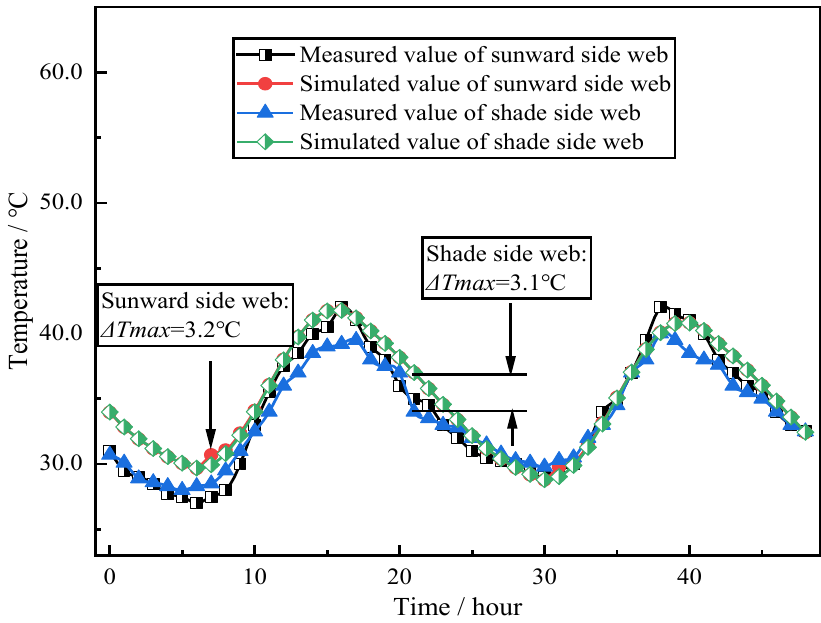
Figure 16. Temperature change curve of floor and roof.